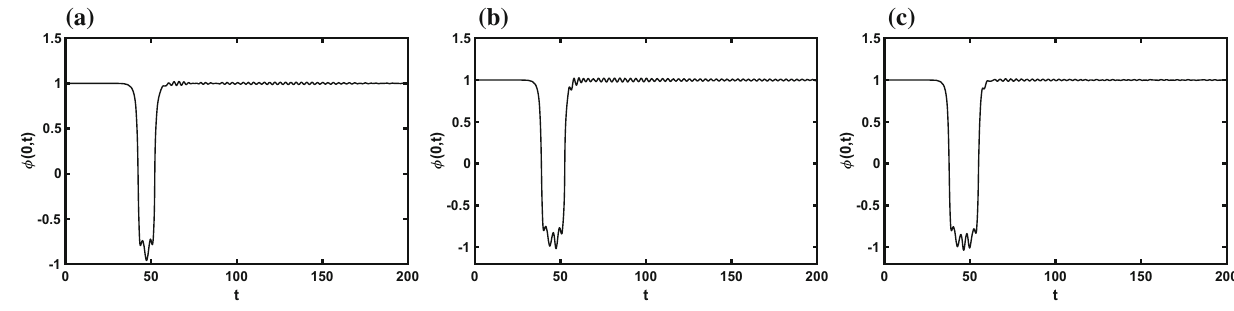
Fig. 11 Kink-antikink collisions: scalar field at the center of mass φ( 0 , t ) as a function of t for a v = 0 . 265, b v = 0 . 29 and c v = 0 . 299 with N = 3, N = 4 and N = 5 oscillations,